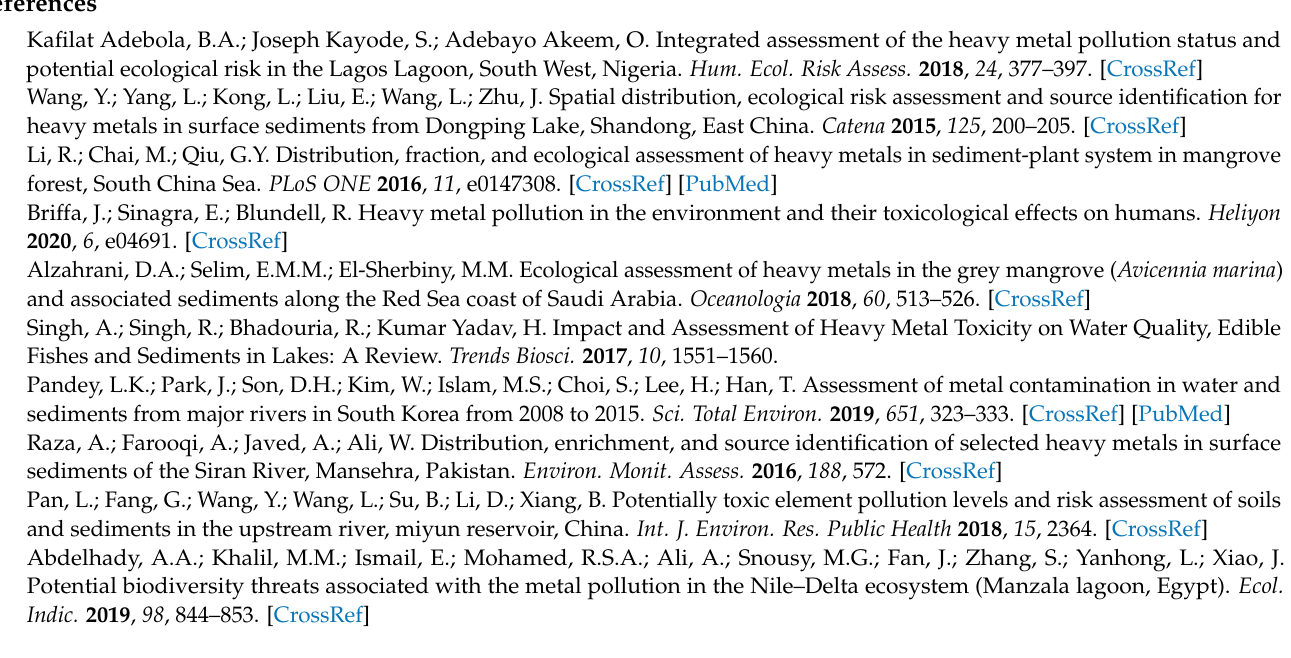
Figure S2: Correlation matrix of PLI, mCd and Ri calculated from sediment samples (a: Tragadero la- degree), Figure S3: Linear regression between PLI and Ri values of the lagoons, Table S1: